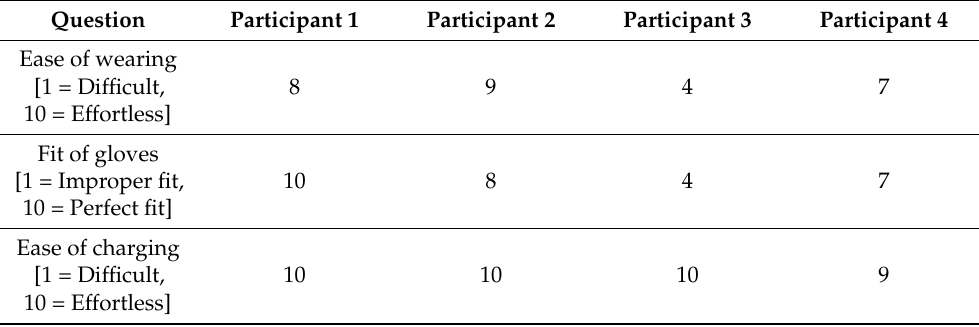
Table 7. Glove usability responses.